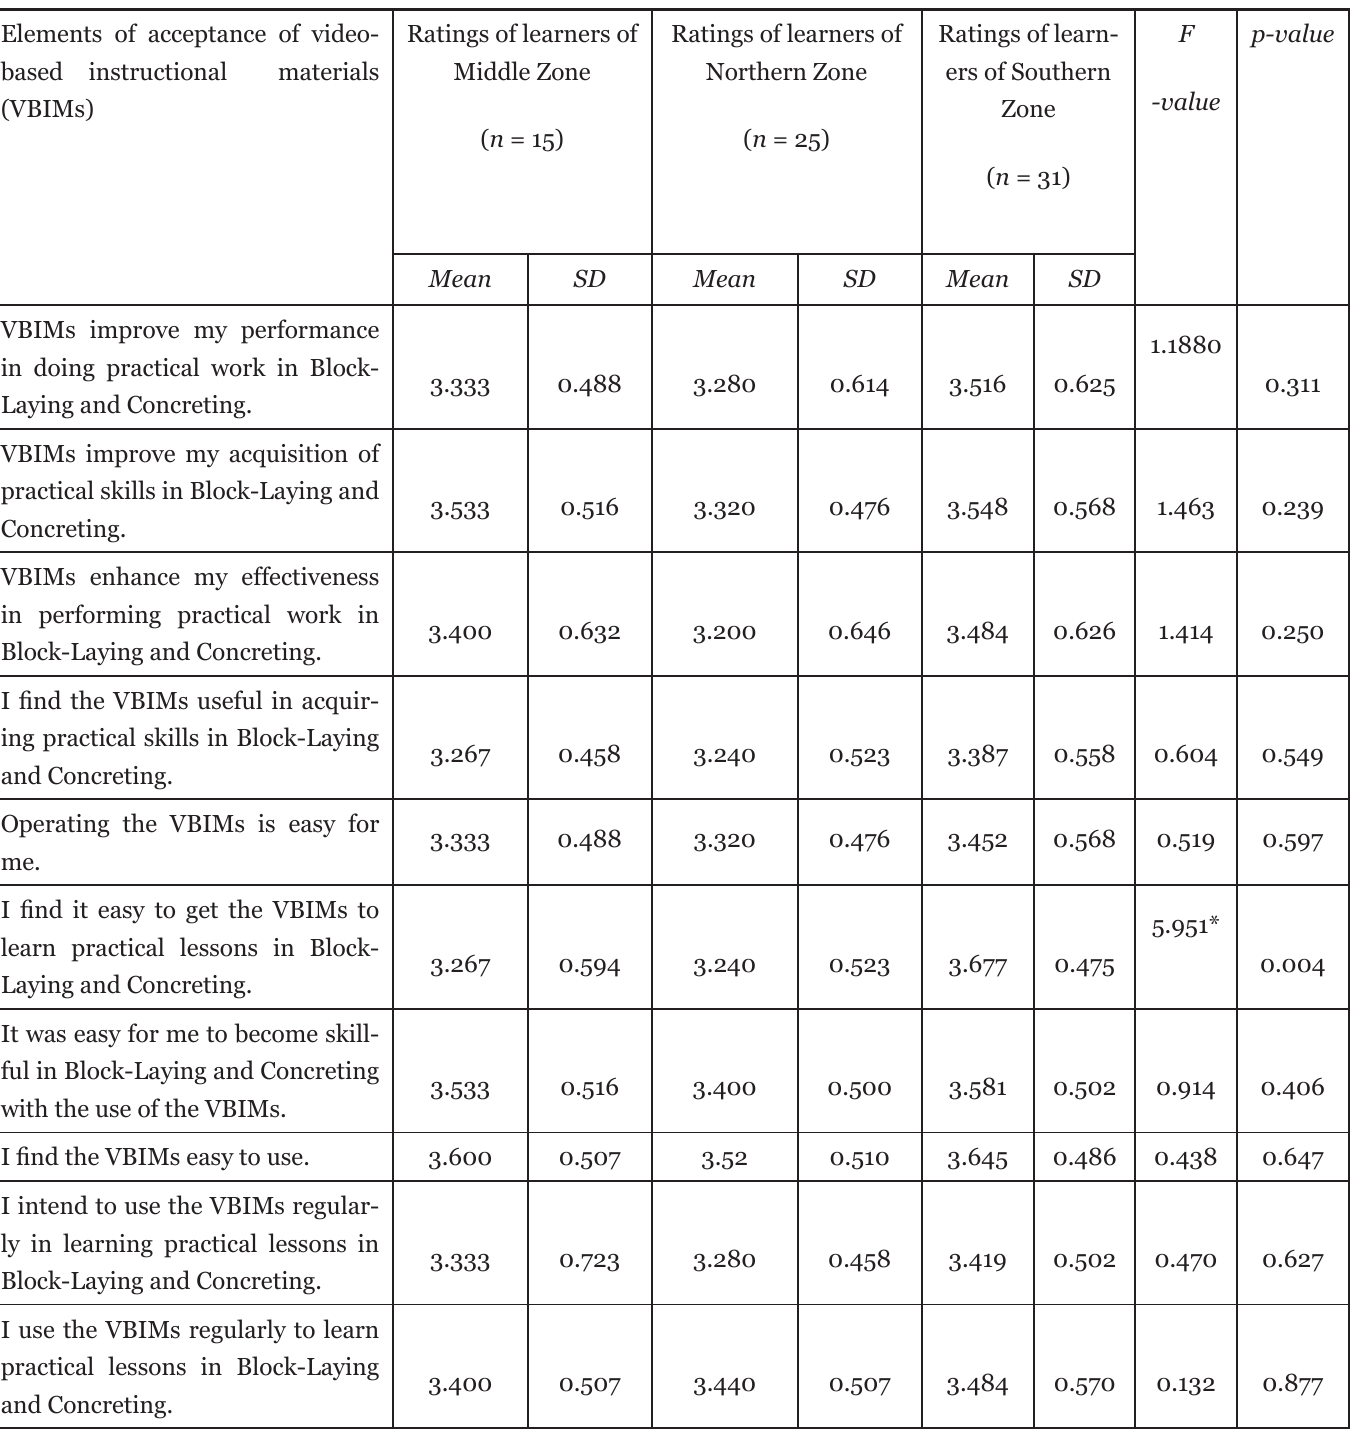
Table 2 Results of ANOVA for Ratings of Items of the Learner Acceptance Scale Categorized according to Study Centres Elements of acceptance of